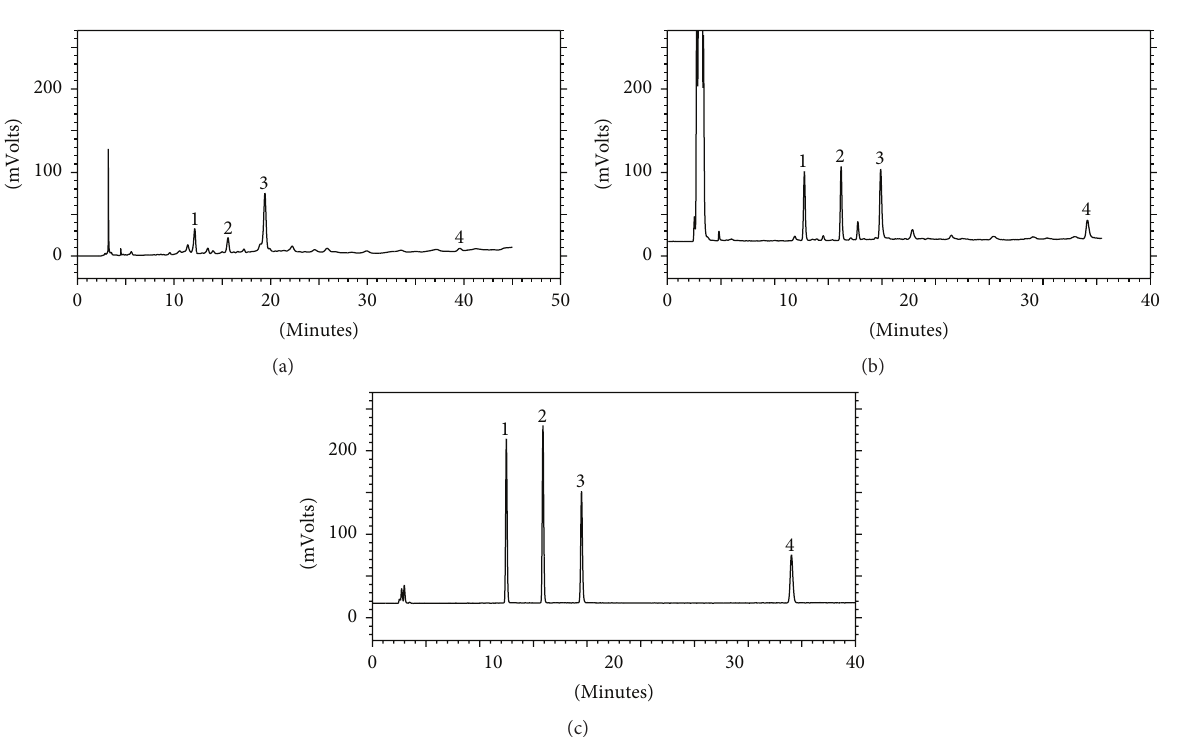
Figure 3: HPLC chromatograms diagrams. Sample at 271 nm (a); sample with ELSD (b); standard solution with ELSD (c). Peak: (1) 3,4- dihydroxyphenylethyl alcohol glycoside; (2) salidroside; (3) chlorogenic acid; (4)